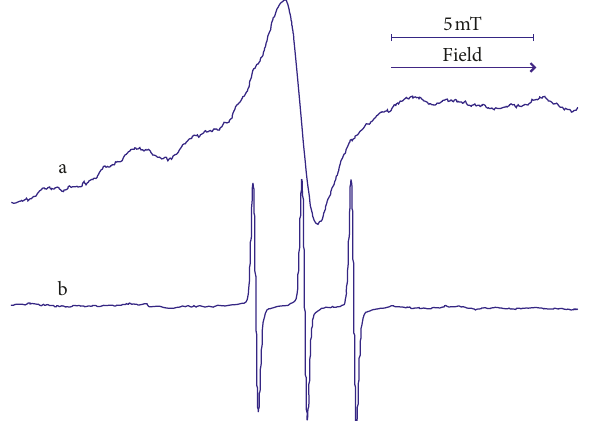
Figure 4: ESR spectra of spin probes 1 (a) and 2 (b) in the physiological solution.